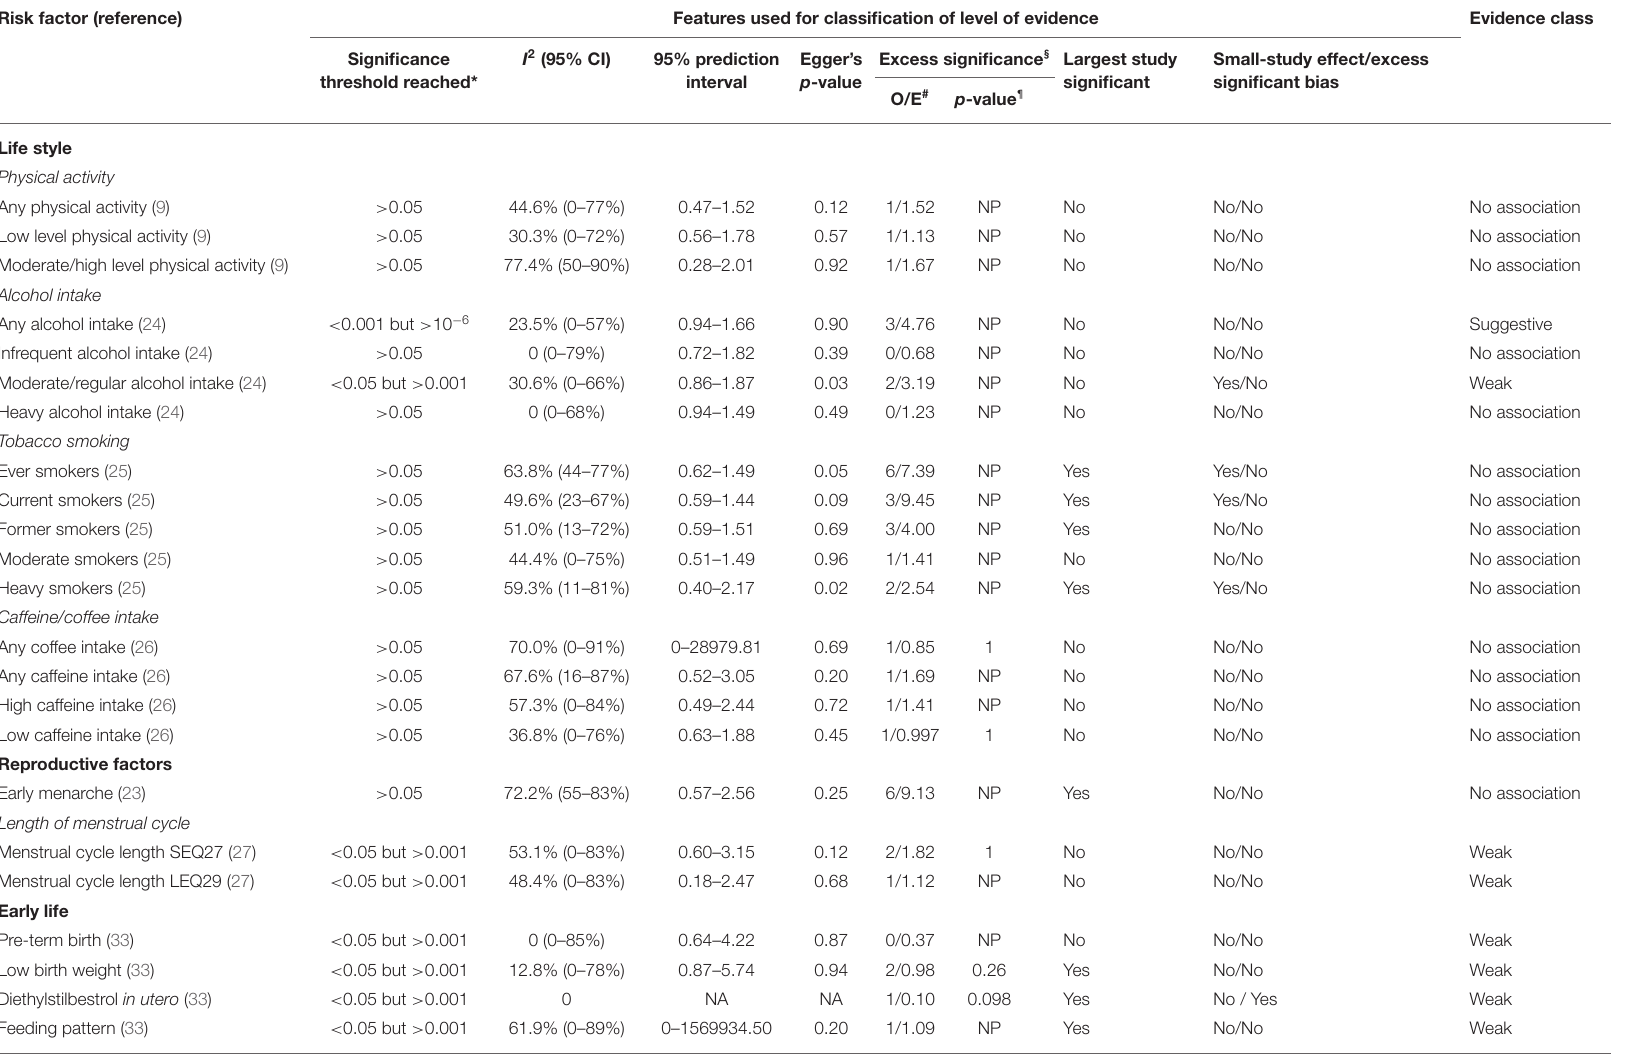
TABLE 2 | Level of evidence for the association of risk factors for